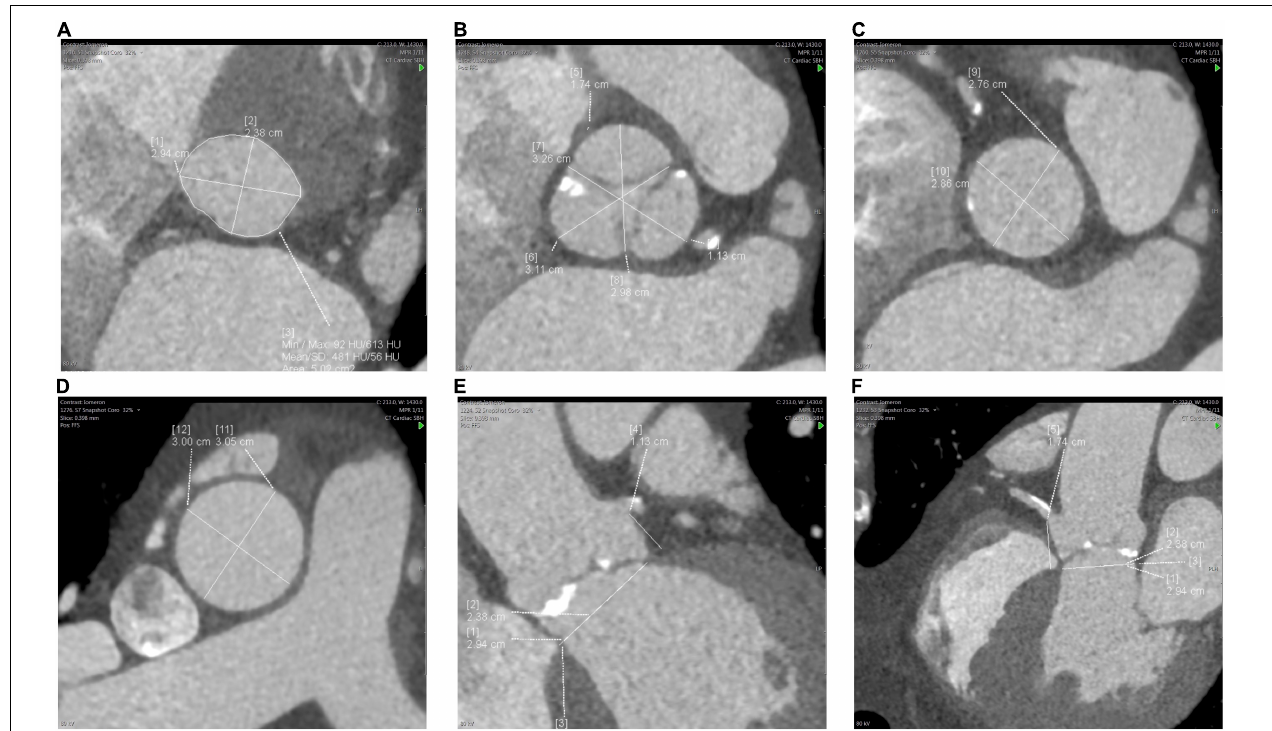
FIGURE 2 | Measurements of the aortic root and ascending aorta. (A) aortic valve (AV) annulus, (B) sinus of Valsalva, (C) sino-tubular junction, (D) ascending aorta, (E) left coronary ostial height from AV annulus, (F) right coronary ostial